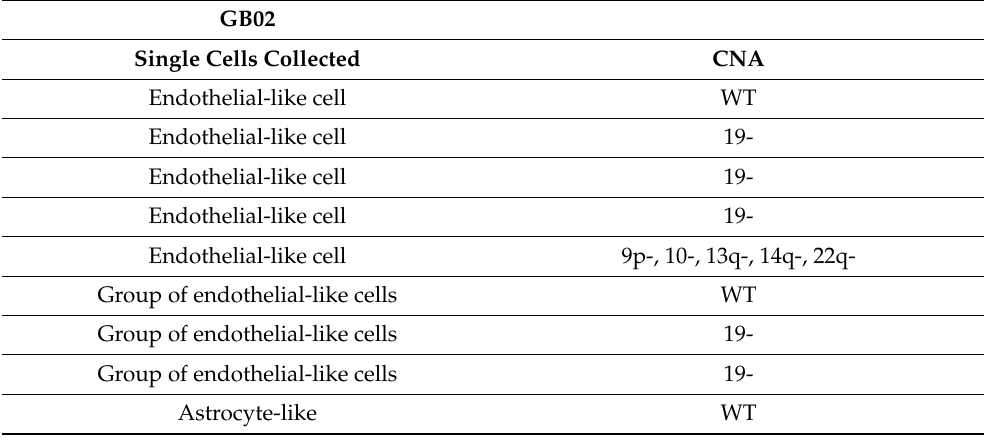
Table 3. CNAs results obtained after CNApp processing for single cells and groups of single cells collected in the GB02